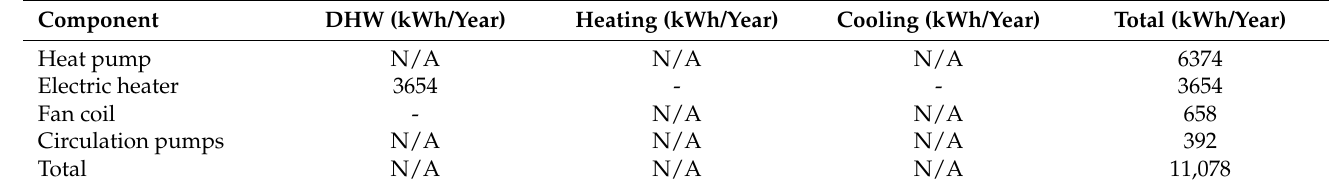
Table 6. Annual electricity consumption from the grid of the innovative system.